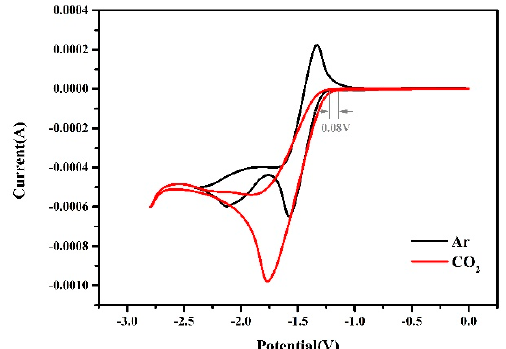
Figure 1. Cyclic voltammogram of o -methylbenzophenone on a glassy carbon (GC) electrode under argon (black trace) or with CO 2 bubbling (red trace). The reaction solution consists of supporting electrolyte (0.1 M of Bu 4 NBr) and o -methylbenzophenone (40.0 mM) in 20 mL of acetonitrile by using Ag/AgBr as the reference electrode and Al as the counter electrode.